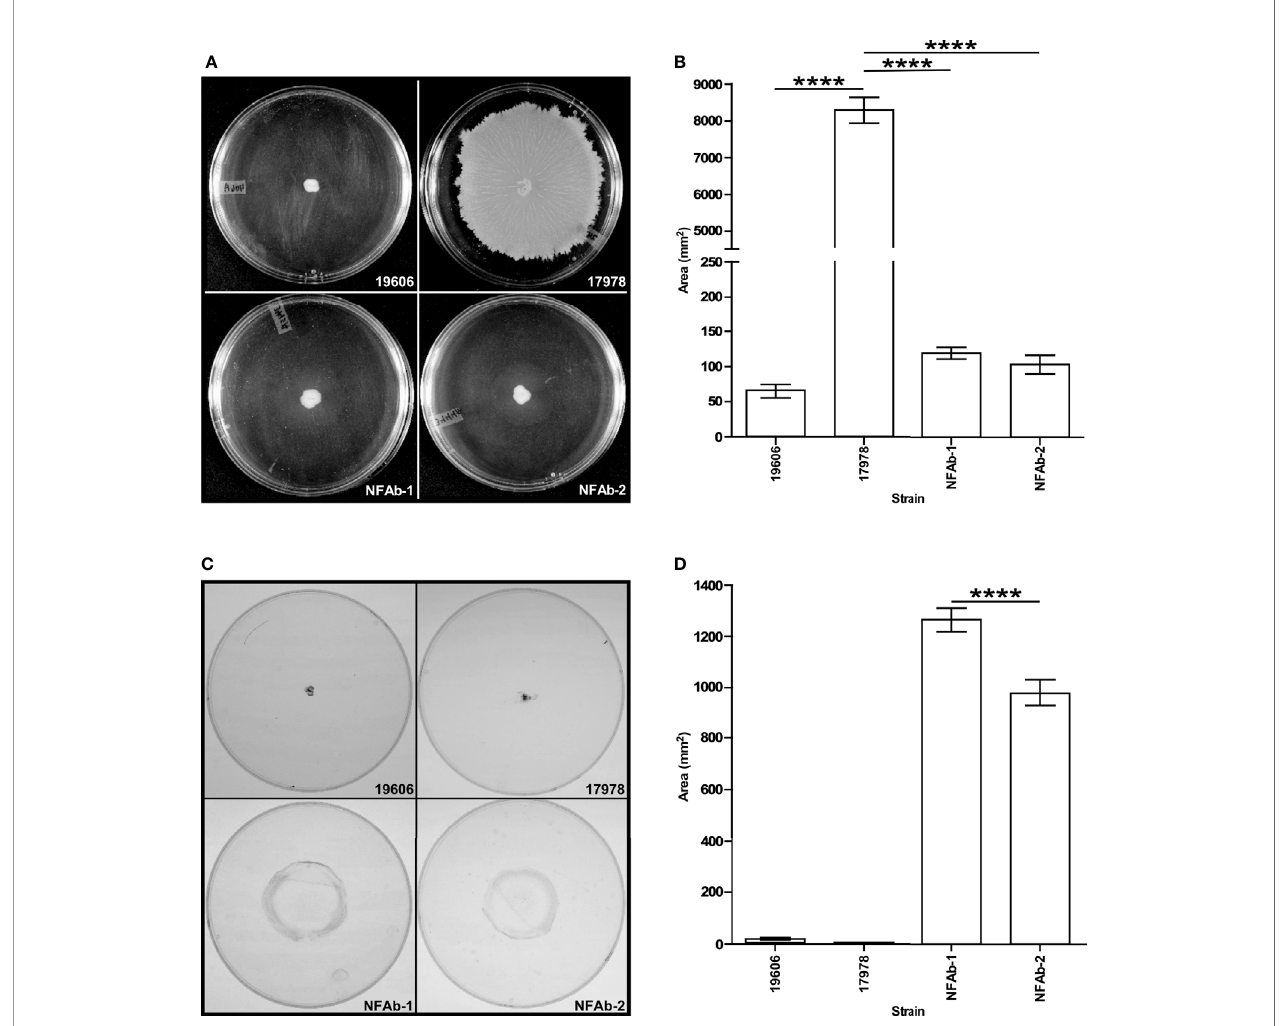
FIGURE 3 | Surface and twitching motility of A. baumannii strains. MMA plates were stab inoculated with cells from the ATCC 19606 T , ATCC 17978, NFAb-1 or NFAb-2 strains and incubated overnight at 37°C. After recording surface motility (A, B) , the agarose layers were removed, the plates were gently washed with distilled water and then stained with crystal violet to determine twitching motility (C, D) . Images in (A, C) display representative results while data presented in (B, D) were collected using three independent biological replicates with each of them tested in triplicate. ATCC 19606 T , NFAb-1 and NFAb-2 cells displayed growth but not surface motility. Horizontal bars identify statistically different values (**** P ≤ 0.0001) and error bars represent the standard error of each data